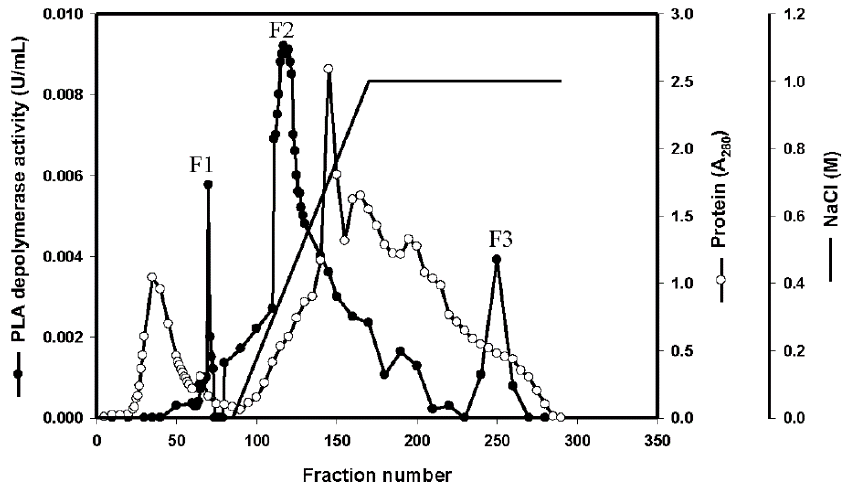
Figure 2. Elution profile of TKU015 PLA depolymerase from DEAE-Sepharose CL-6B. Table 1. Purification of PLA depolymerase from P. tamsuii TKU015 a .